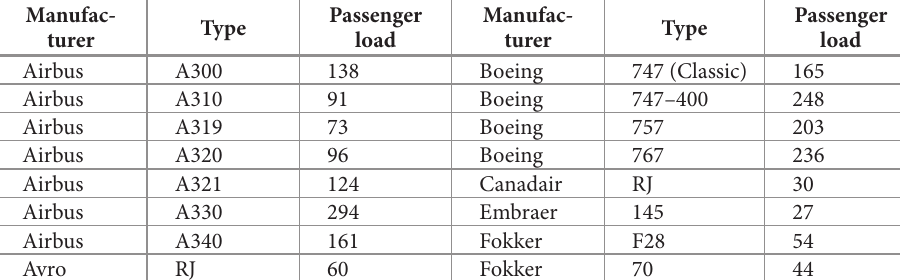
Table 7. Average passenger load per flight